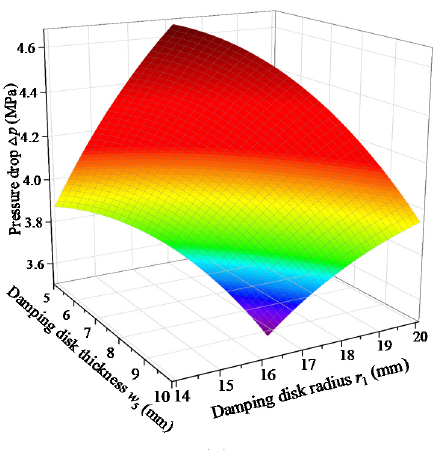
Figure 10. Fitting surface of model for g a = 1.25 mm, w 5 = 7.5 mm: ( a ) pressure drop  p , ( b ) power consumption P w.